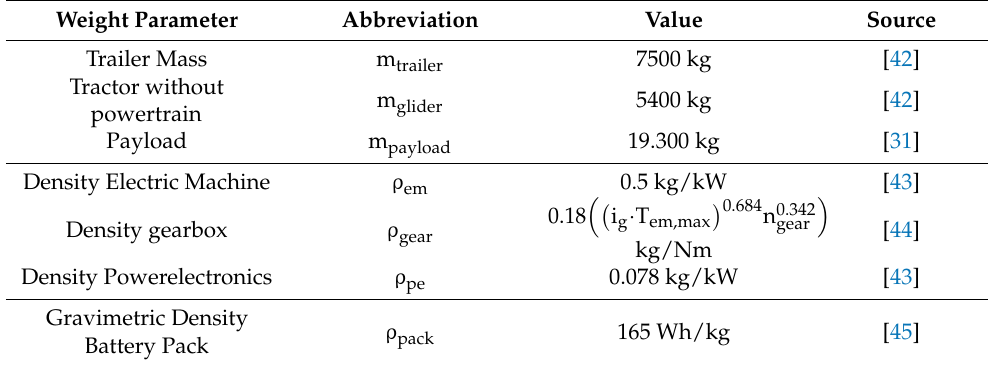
Table A2. Mass of vehicle